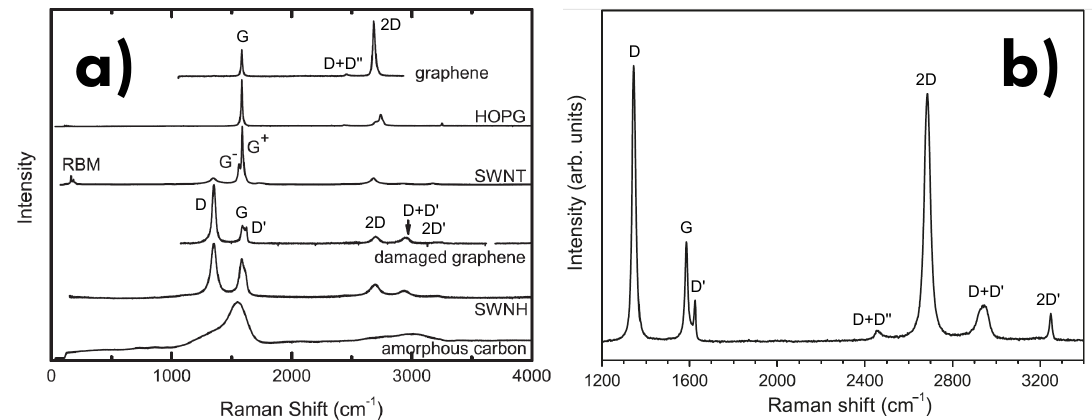
Figure 13. ( a ) Raman spectra of (from top to bottom) monolayer graphene, highly oriented pyrolytic graphite (HOPG), single-wall carbon nanotube (SWNT), single-wall carbon nanohorns (SWNH) and hydrogenated amorpous carbon. The label for the main bands is reported. Adapted with permission from Ref. [55]. Copyright (2010) American Chemical Society. ( b ) Raman spectra of defected monolayer graphene. Adapted with permission from Ref. [54]. Copyright (2017) Cambridge University